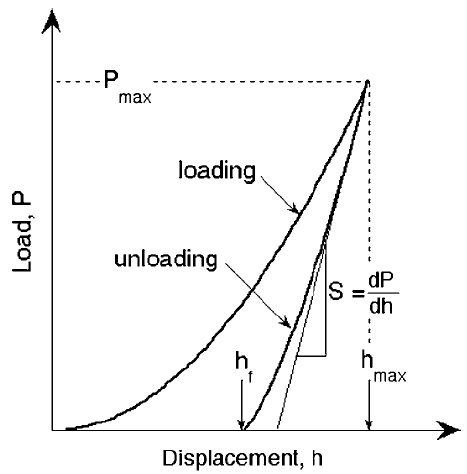
Figure 1. Load-displacement curve [5].